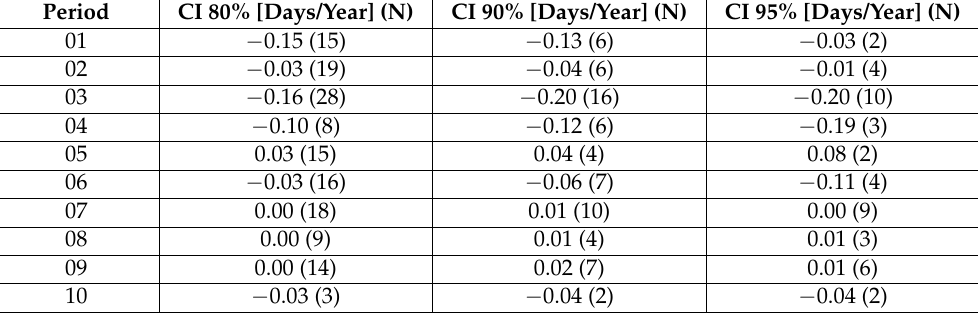
Figure A2. Histograms of derived Theil–Sen slopes of the basin-based trend analysis of SCD for the 19 observed periods. The color coding represents the confidence intervals, and a normalization with the largest value was carried out. Table A2. Arithmetic mean of the slopes (scaled to days per year) of the basin-based trend analysis for the three confidence intervals. N shows the total number of basin